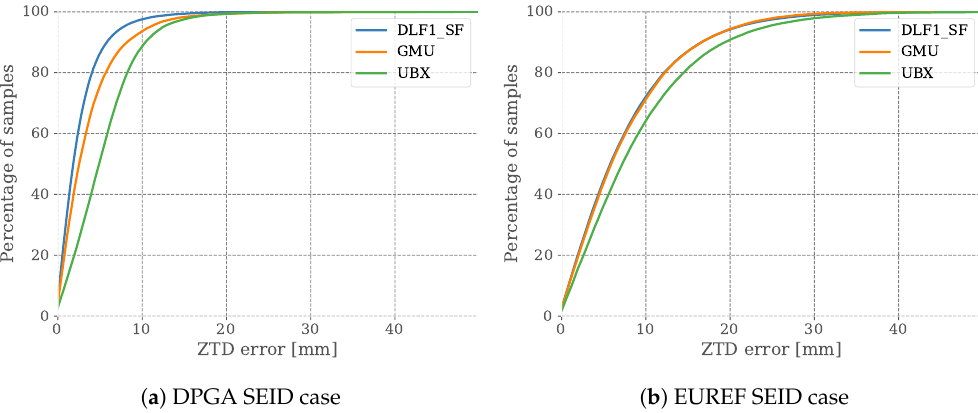
Figure 7. Cumulative error distribution plots of the single-frequency ZTD estimations DLF1_SF, GMU, and UBX compared to the DLF1_DF reference dataset. The figure at the left ( a ) depicts the DPGA SEID constellation results, while ( b ) is from the EUREF SEID case, respectively.